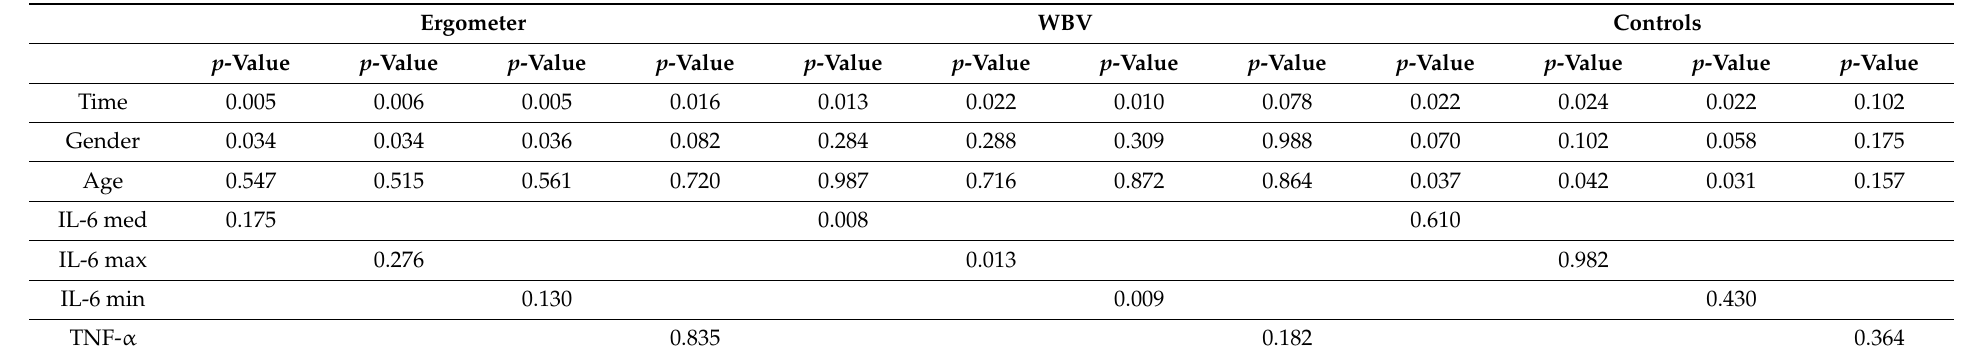
Table 6. Influences of IL-6 and TNF- α on DIKJ in ergometer, WBV, and controls (fixed effects mixed model